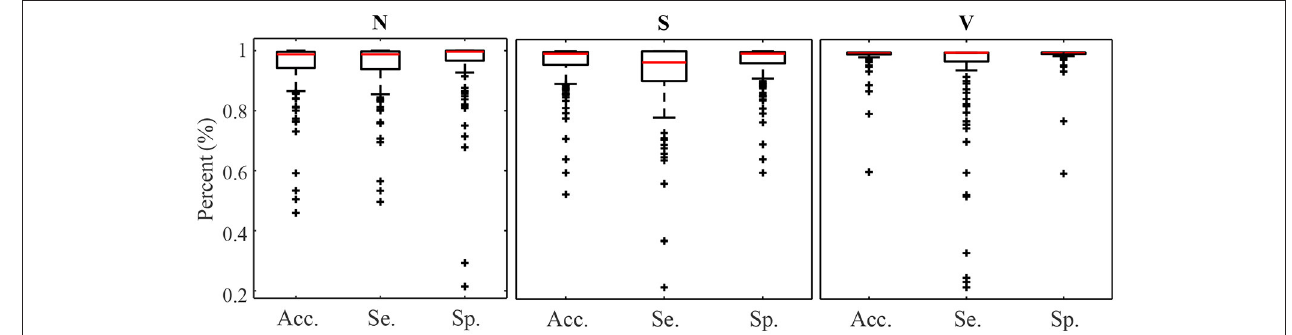
FIGURE 6 | Accuracy Sensitivity and Specificity box plot for N , S , and V detection calculated for each patient